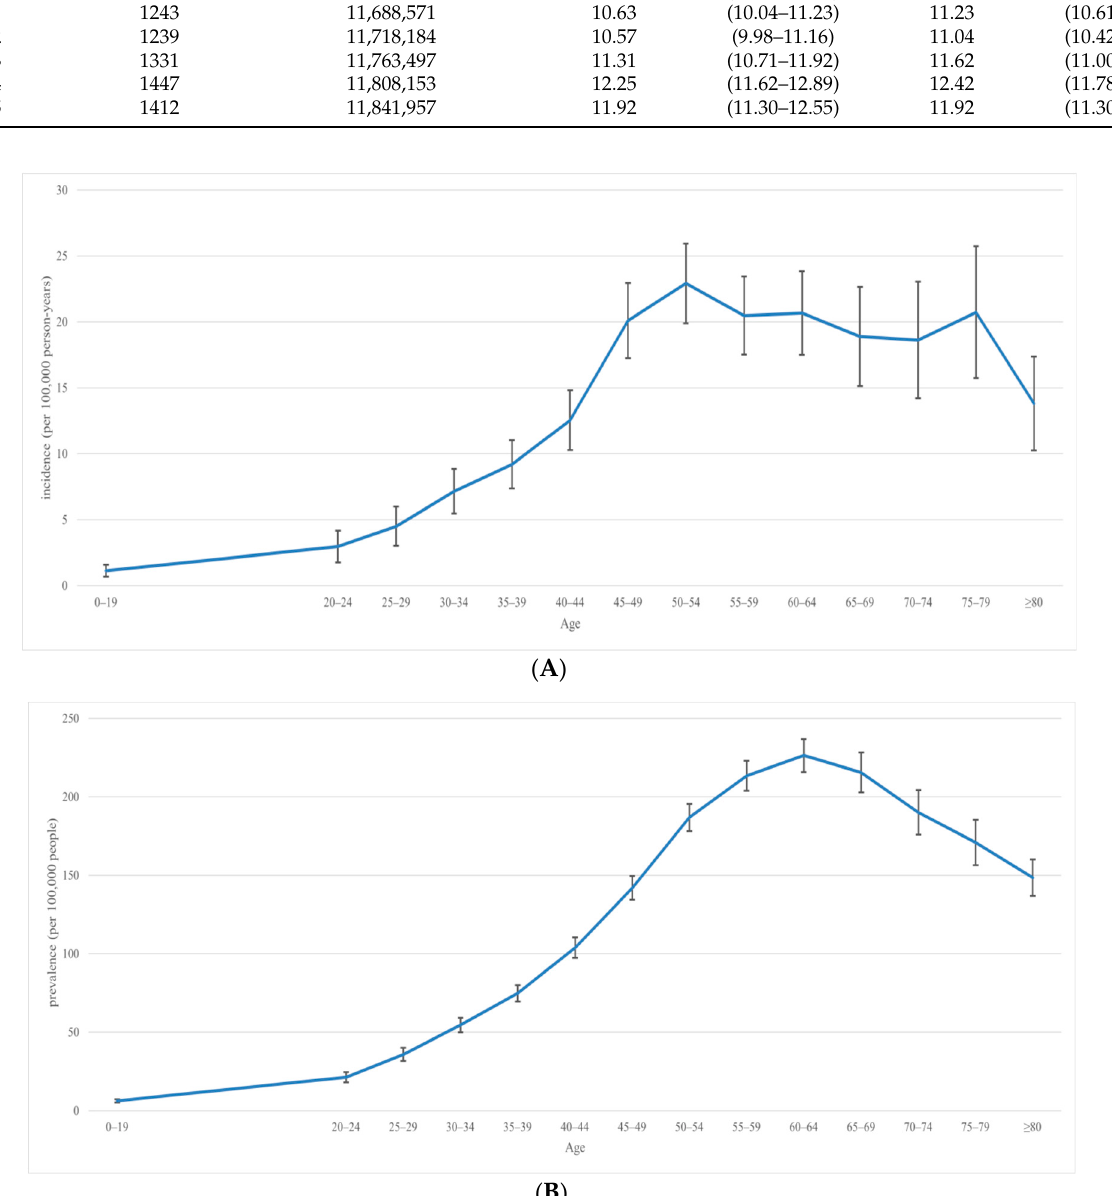
Figure 1. Differences in the trends of ( A ) incidence and ( B ) prevalence of ovarian cancer according to age groups in Taiwan in 2015.